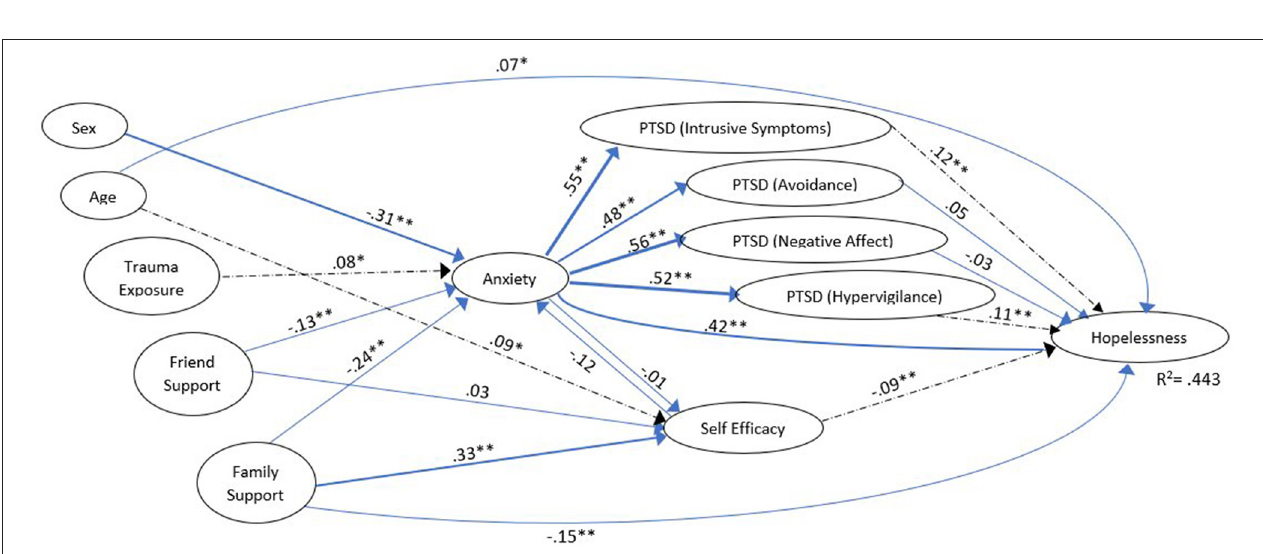
figure: exogenous variable covariances, residuals on the endogenous variables,correlations among the residuals on the PTSD variables, the indicators and measurement error variances for the indicators.* p < 0.05, ** p < 0.001.